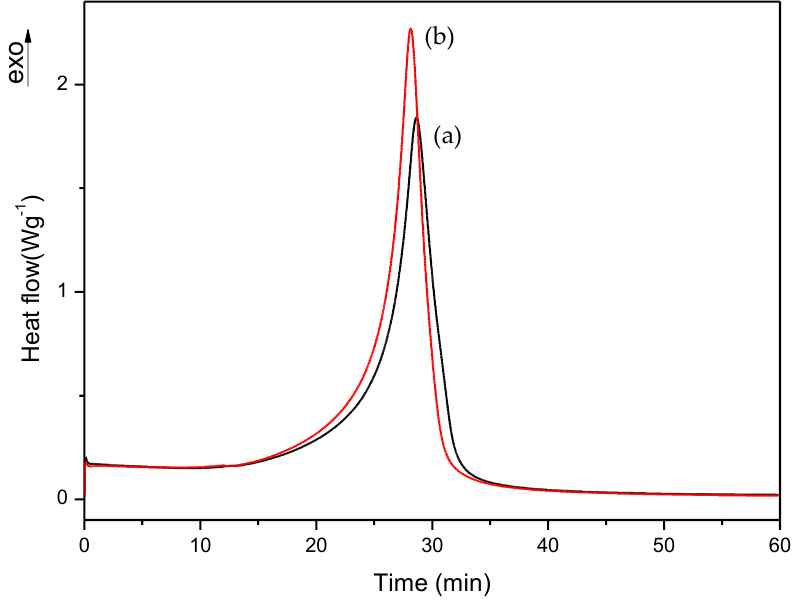
Figure 6. Isothermal DSC curves for (a) commercial and (b) A formulations.